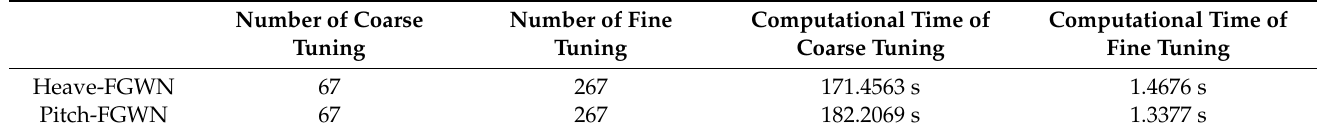
Table 11. Computational time with experimental